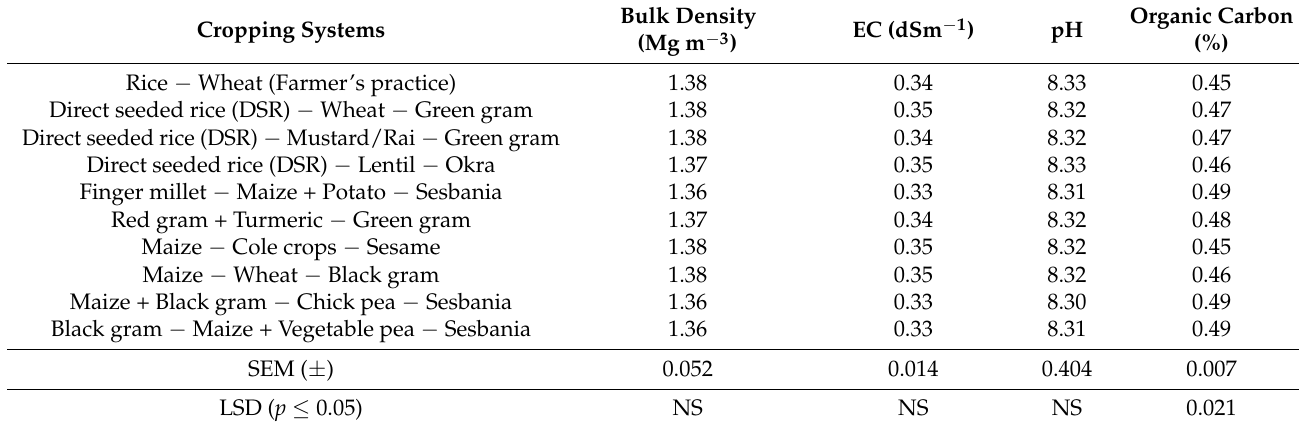
Table 7. Post-harvest physicochemical properties of the diversified cropping system